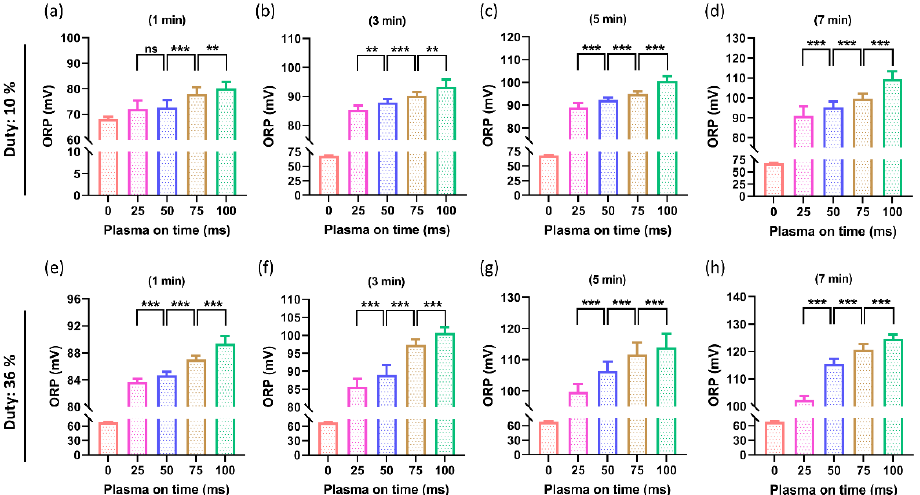
Figure 5. The ORP of PTM (DMEM). ( a – d ) The ORP when the duty ratio was set to 10% and ( e – h ) when the duty ratio of 36%. Increasing plasma on-time (25, 50, 75, and 100 ms) resulted in a significant increase in the ORP of the PTM. The significance was calculated using Microsoft Excel (MS Office 365), while the differences between the treatment groups are indicated by ** p < 0.01, *** p < 0.001, ns—not significant.